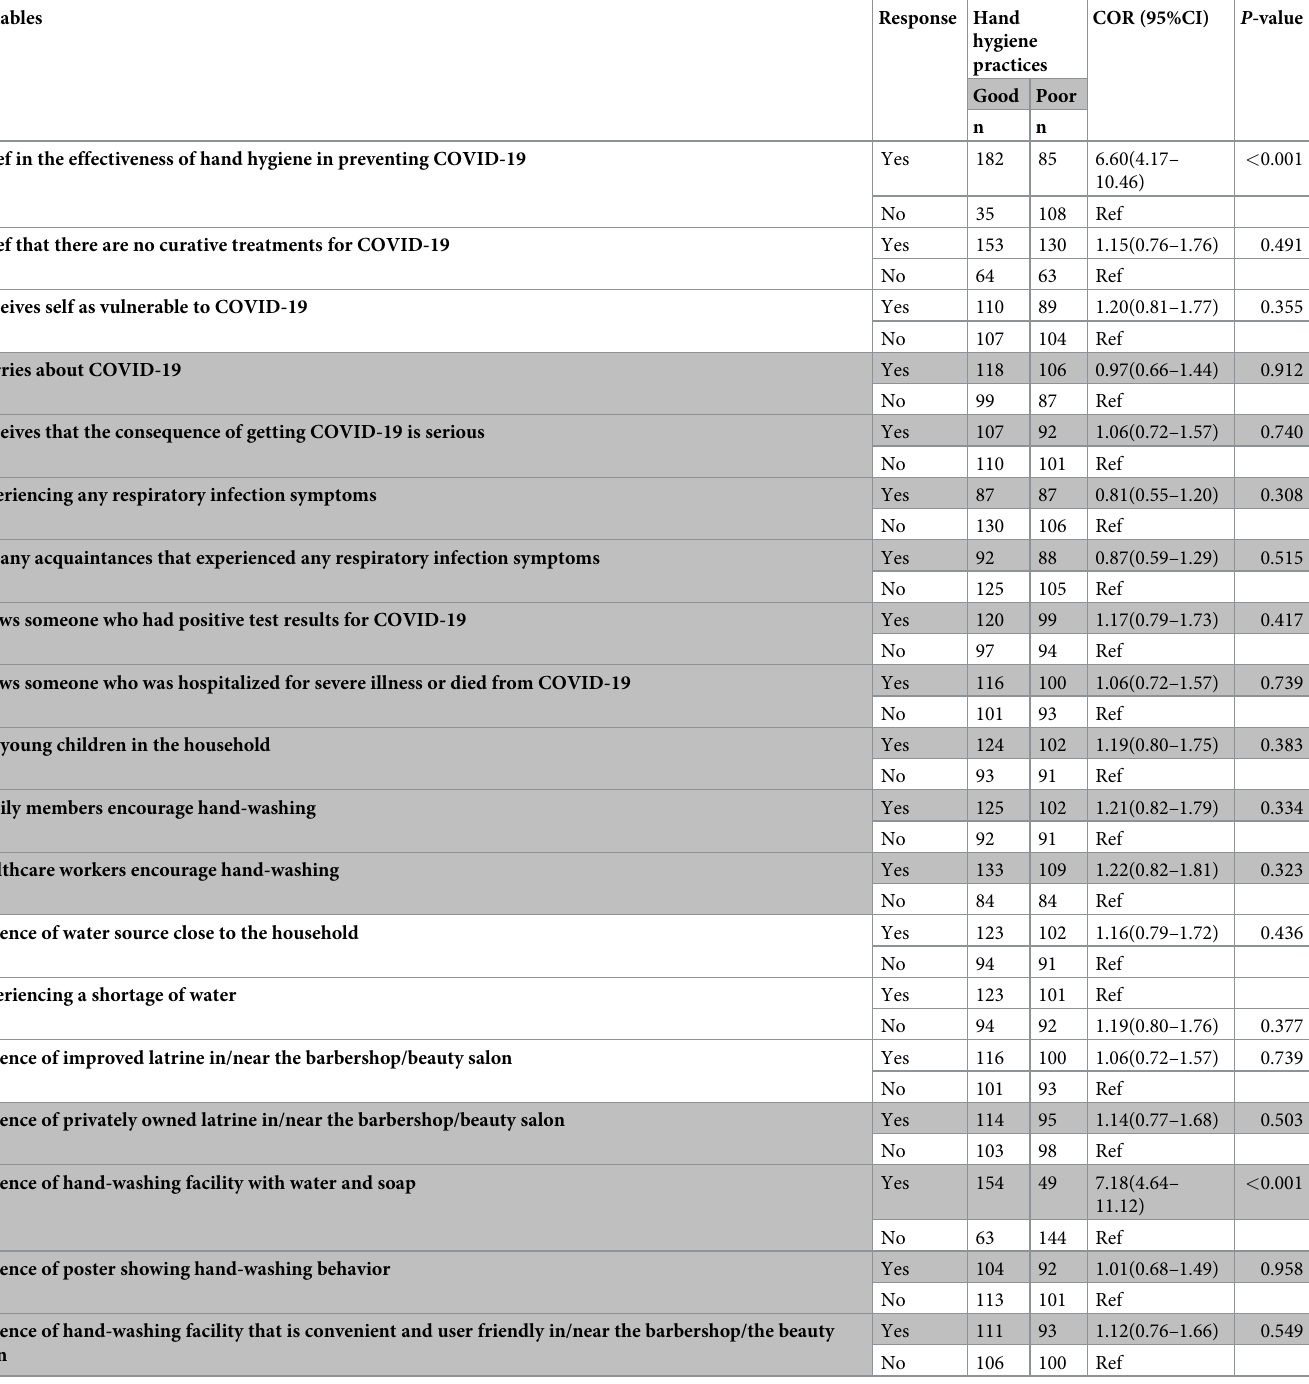
Table 6. Factors associated with good hand hygiene practices among barbers and beauty salon workers in bivariate logistic regression analysis in Dessie City and Kombolcha Town, Northeastern Ethiopia, January 5 to February 10,